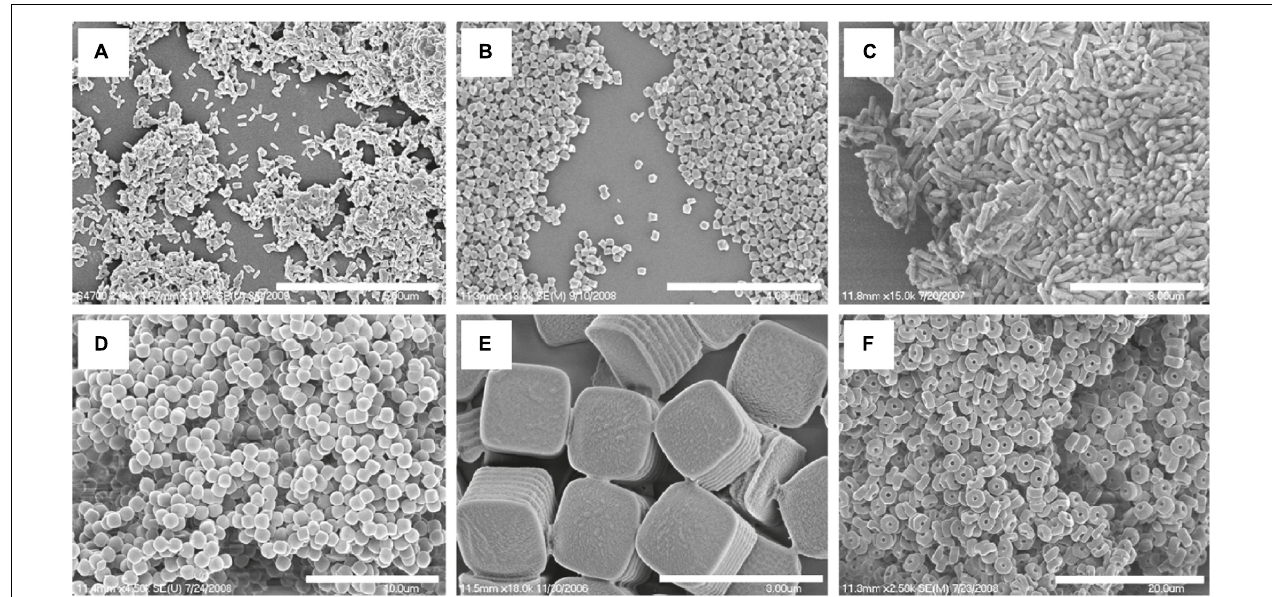
FIGURE 11 | SEM Images of PLGA PRINT particles. (A–C) Cylinders of different dimensions. (D) Spheres; (E) ridged cubes; ( F , bottom right) particles with center fenestrations, reprinted with permission from Enlow et al. (2011). Copyright (2019) American Chemical Society.